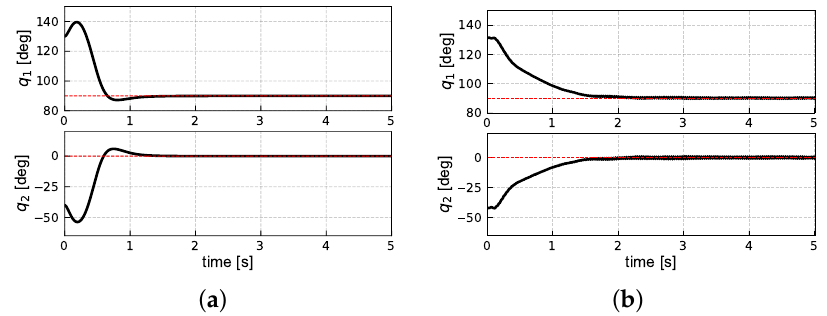
Figure 11. Case B2: Angular positions: ( a ) simulation, ( b ) experiment.